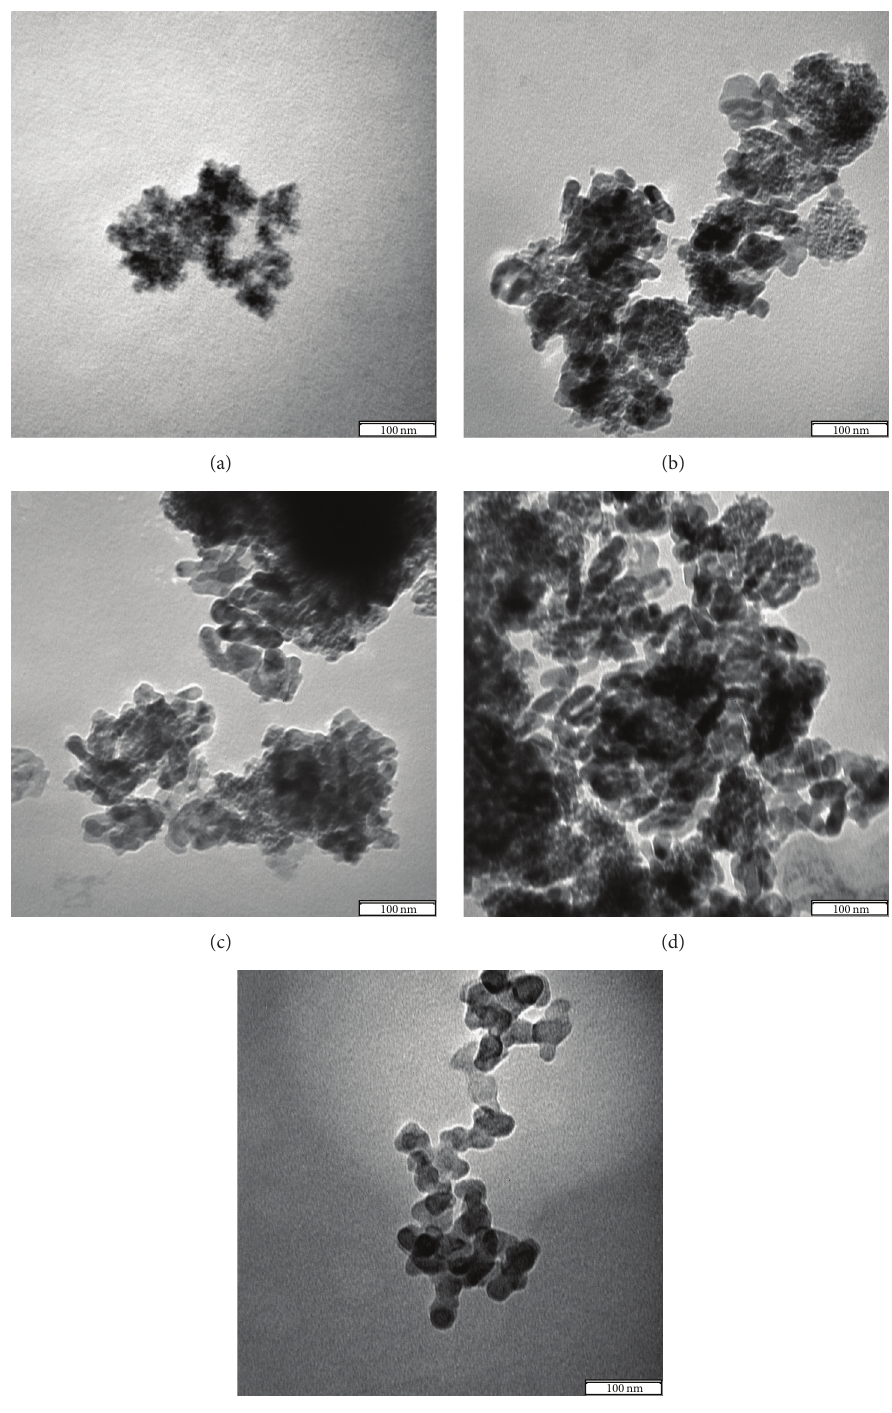
Figure 3: TEM images of (a) TiO 2 particles, (b) TCd1, (c) TCd2, (d) TCd3, and (e) TCd4 nanocomposites taken at 200K magnification. Scale bar 100